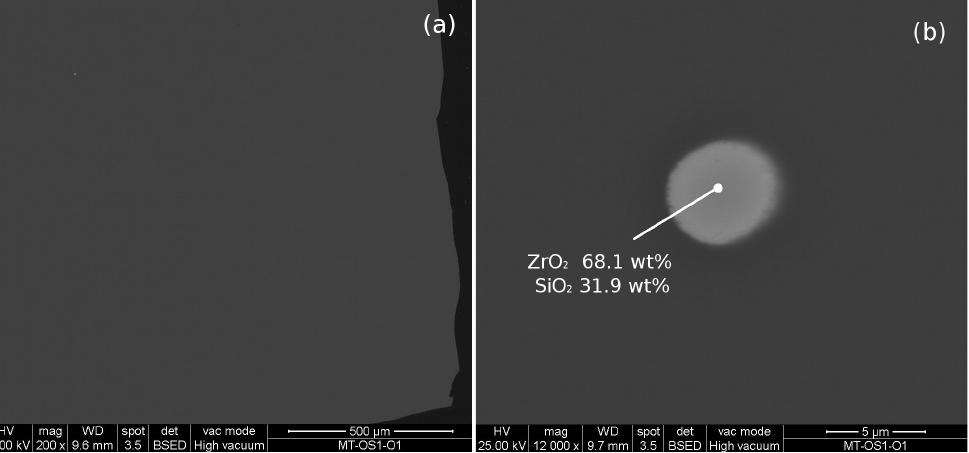
Figure 11: (a) SEM-BSE image of sample MT-OS1-O1. Note the homogeneity of the glass and the absence of air-bubbles and inclusions, except for sporadic ones, circular in shape and very thin in size, shown in (b). SEM-EDS data also reported in